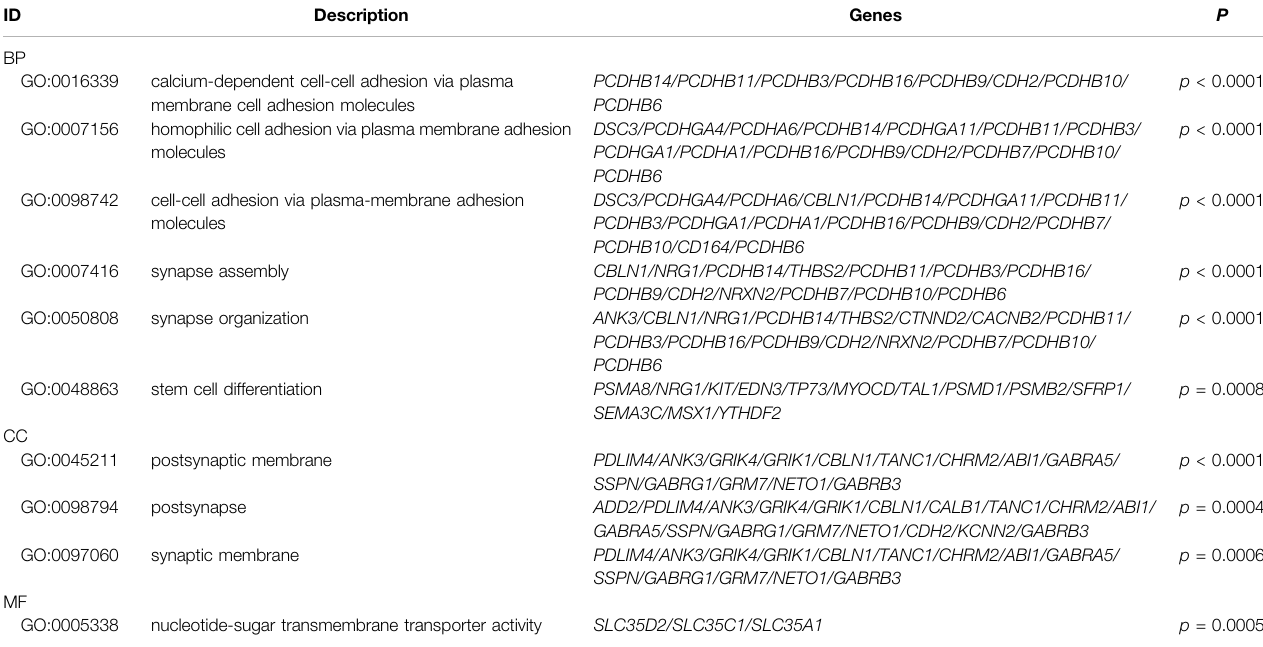
TABLE 2 | Top 10 enriched GO pathways of differential methylation loci-related genes. ID Description